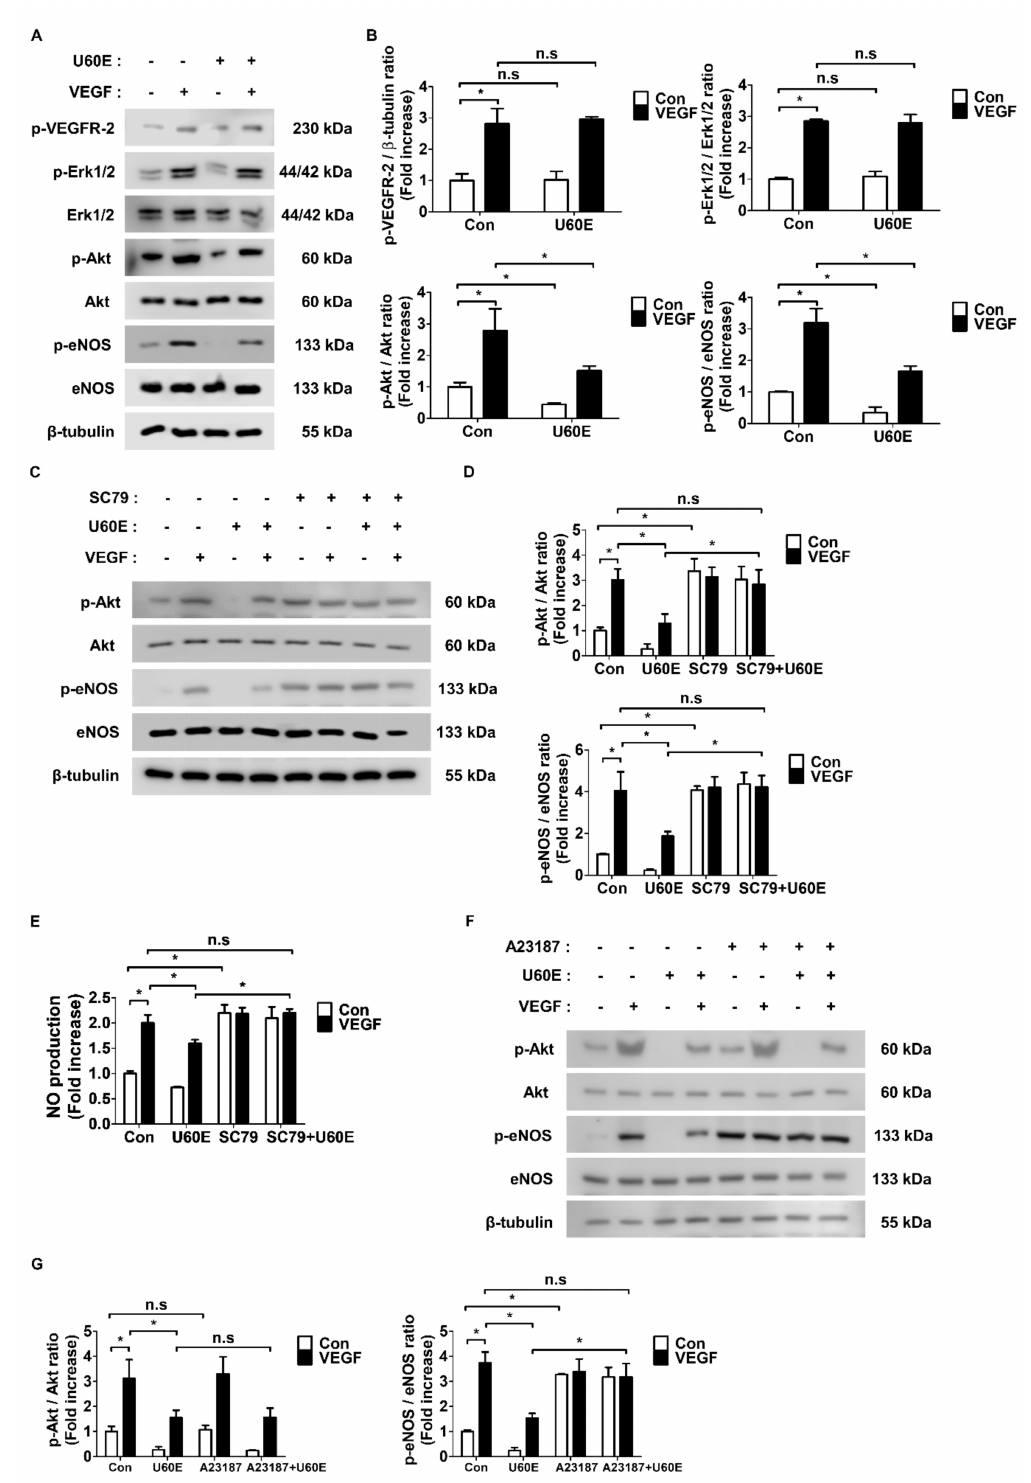
Figure 4. Involvement of Akt signaling in U60E-mediated decrease in eNOS activation and NO production in HUVECs. ( A ) HUVECs were treated with VEGF (20 ng/mL) and/or U60E (20 µ g/mL) for 30 min. The phosphorylation of VEGFR-2 (p-VEGFR-2), Erk1/2 (p-Erk1/2), Akt (p-Akt), and eNOS (p-eNOS) was determined by Western blot analysis. Erk1/2, Akt, eNOS, and β -tubulin were used as controls. ( B ) Quantitative densitometric analysis of Western blots in ( A ). The bar graph represents the means ± SD ( n = 3). ( C ) HUVECs were treated with VEGF (20 ng/mL), U60E (20 µ g/mL), and/or SC79 (Akt activator, 1 µ g/mL) for 30 min. The phosphorylation of Akt (p-Akt) and eNOS (p-eNOS) was determined by Western blot analysis. Akt, eNOS, and β -tubulin were used as controls. ( D ) Quantitative densitometric analysis of Western blots in ( C